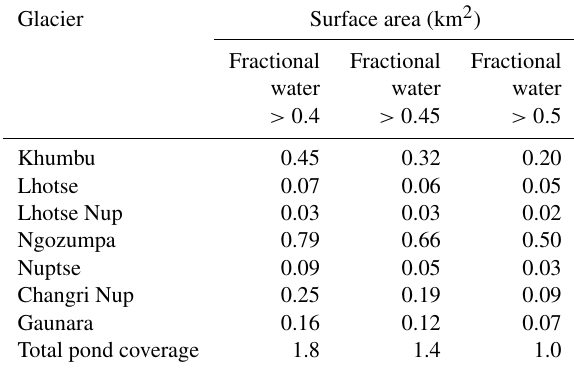
Table 3. Sensitivity analysis of the supraglacial pond area for the seven reference glaciers in the Khumbu domain, obtained using var- ious thresholds applied to the fractional water